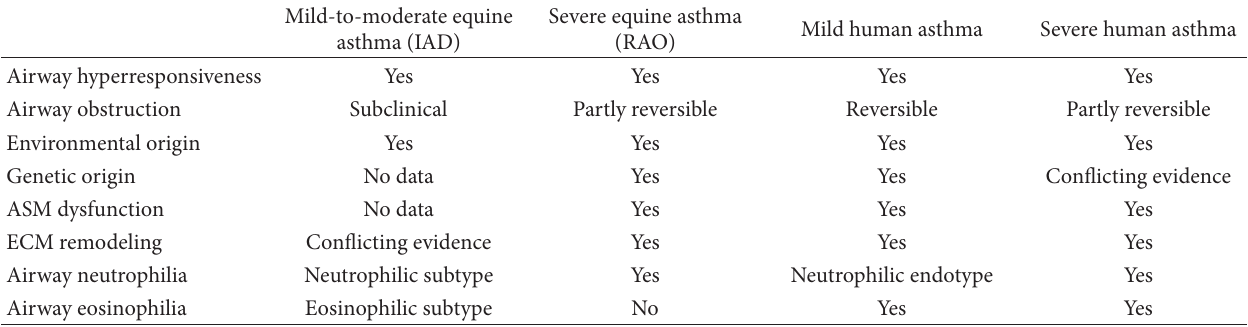
Table 1: Parallels and differences between equine and humane asthma. IAD = inflammatory airway disease, RAO = recurrent airway obstruction, ASM = airway smooth muscle, and ECM = extracellular